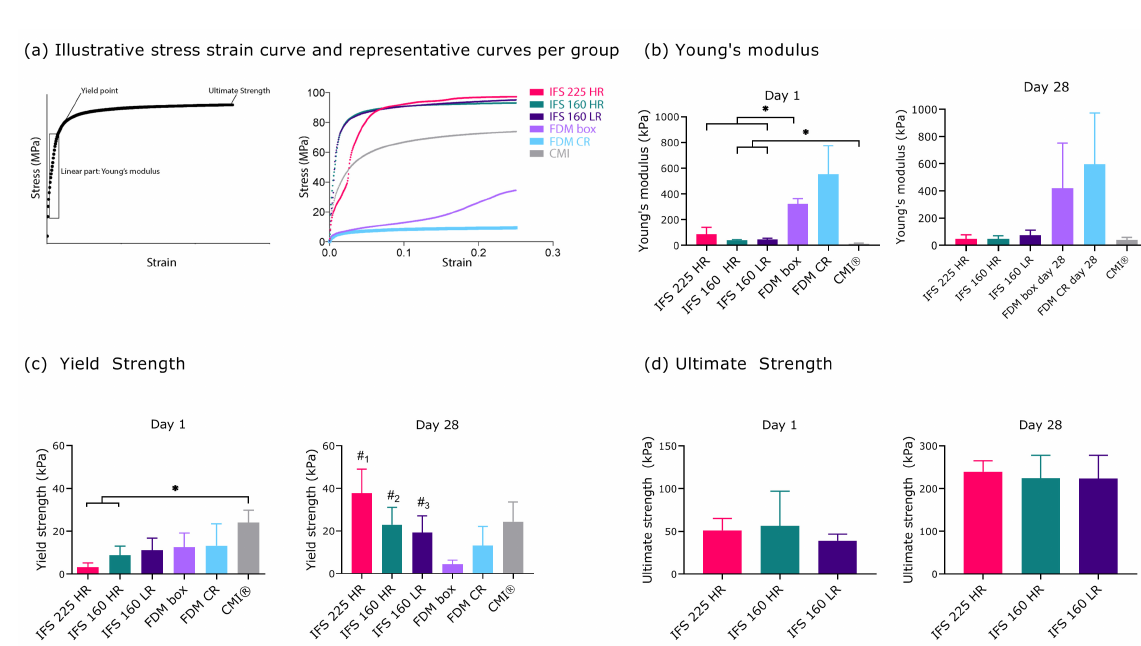
Figure 3. Mechanical characteristics of scaffolds seeded with co-cultured mesenchymal stromal cells and meniscus cells (80:20) in fibrin gels 1 day after seeding and after 28 d of culture ( n = 3 donors per group, 3 technical replicates per donor) . ( a ) Illustrative stress strain curve and representative stress strain curves of measured groups. ( b ) Young’s Modulus ( c ) Yield Strength ( d ) Ultimate strength. *, p < 0.05; # 1 , p < 0.05 compared to all groups; # 2 , p < 0.05 compared to all groups except CMI ® and FDM CR; # 3 , p < 0.05 compared to FDM box and IFS 225 HR. Abbreviations; 160: 160 µ m, 225: 225 µ m, CMI ® : Collagen Meniscus Implant ® , IFS: inter fibre spacing, HR: high ratio of radial fibres, LR: low ratio of radial fibres, FDM: fused deposition modelling, CR: circumferential and radial fibres, Box: